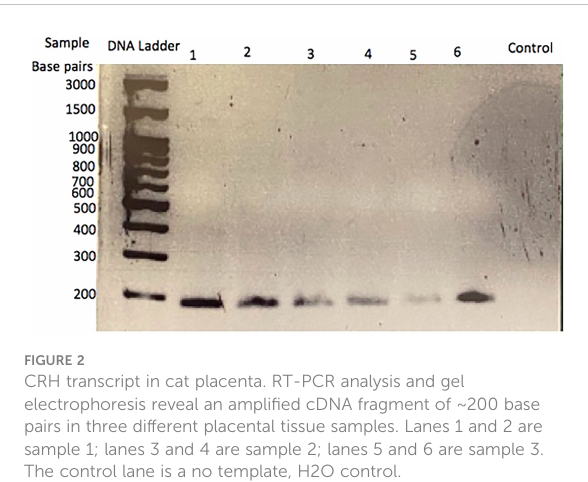
FIGURE 2 CRH transcript in cat placenta. RT-PCR analysis and gel electrophoresis reveal an ampli fi ed cDNA fragment of ~200 base pairs in three different placental tissue samples. Lanes 1 and 2 are sample 1; lanes 3 and 4 are sample 2; lanes 5 and 6 are sample 3. The control lane is a no template, H2O